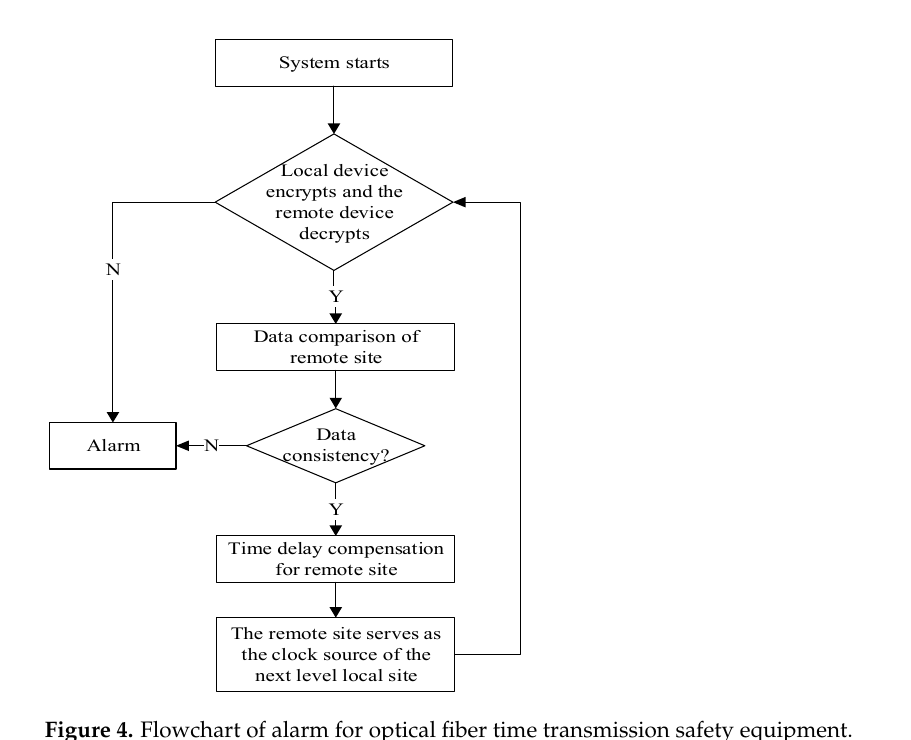
Figure 4. Flowchart of alarm for optical fiber time transmission safety equipment.